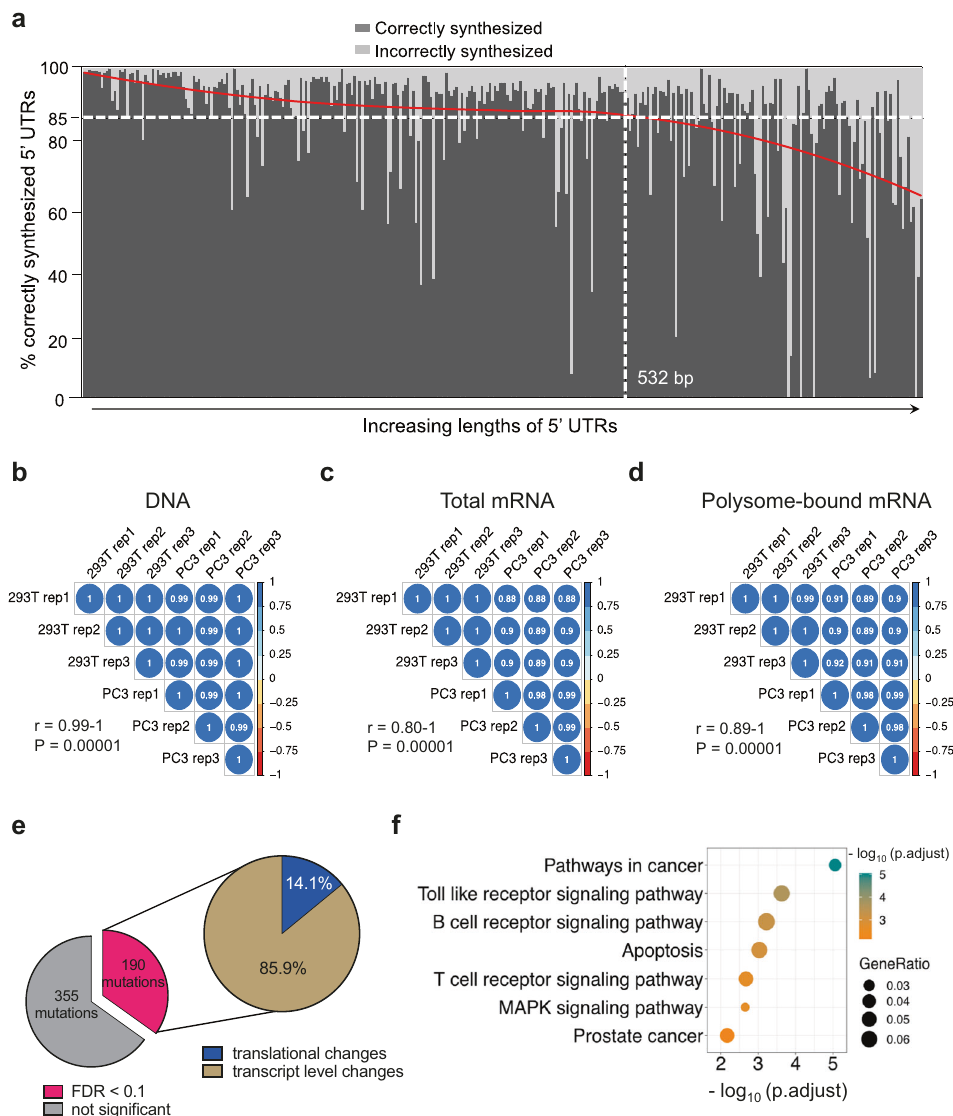
Fig. 3 Thirty- fi ve percent of 5 ′ -UTR mutations across the spectrum of human prostate cancer functionally impact transcription or translation. a Per- gene percentages of distinct barcodes associated with an exact match to an expected 5 ′ -UTR sequence by PacBio long-read sequencing. All distinct 5 ′ -UTR sequences were observed by long-read sequencing and linked to an average of 236 distinct 30-bp barcodes. For each gene, the percentage of barcodes associated with an exactly matching 5 ′ -UTR are plotted as black vertical bars (correctly synthesized). Genes are ordered by increasing 5 ′ -UTR length from left to right, and the average rate of exactly matching barcodes is marked by a horizontal dashed line at 85%. A smoothed fi t, using loess regression, of percentage matching vs rank order of length is shown in red. b Correlation of normalized read counts per WT and mutated 5 ′ -UTR in each technical and biological replicate for each PLUMAGE DNA sample. Three biological replicates were analyzed for each cell line (293T and PC3). Pearson correlation coef fi cient was calculated to determine signi fi cance and was found to be r > 0.99 for all samples (all p values = 0.00001). c Correlation of normalized read counts per WT and mutated 5 ′ -UTR in each technical and biological replicate for each PLUMAGE total mRNA sample. Three biological replicates were analyzed for each cell line (293T and PC3). Pearson correlation coef fi cient was calculated to determine signi fi cance and was found to be r > 0.8 for all samples (all p values = 0.00001). d Correlation of normalized read counts per WT and mutated 5 ′ -UTR in each technical and biological replicate for each PLUMAGE polysome-bound mRNA sample. Three biological replicates were analyzed for each cell line (293T and PC3). Pearson correlation coef fi cient was calculated to determine signi fi cance and was found to be r > 0.89 for all samples (all p values < 0.0001). e Proportion of all 5 ′ -UTR mutations assayed by PLUMAGE that showed a signi fi cant (FDR < 0.1, in pink) change in mRNA transcript or translation levels. f 5 ′ -UTR mutations (190 mutations) that signi fi cantly change gene expression affect important cancer-related pathways by KEGG pathway analysis (Fisher ’ s hypergeometric test, FDR < 0.05). Source data are provided as a Source data fi